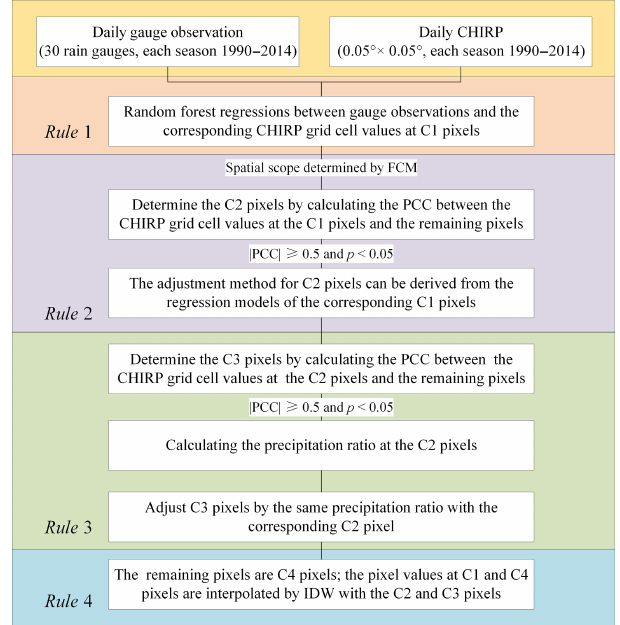
Figure 3. Flowchart of the WHU-SGCC approach with the four rules applied in this